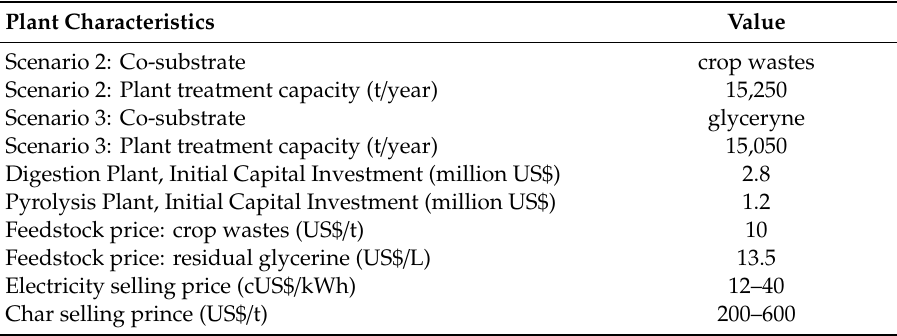
Table 8. Parameters obtained from economic